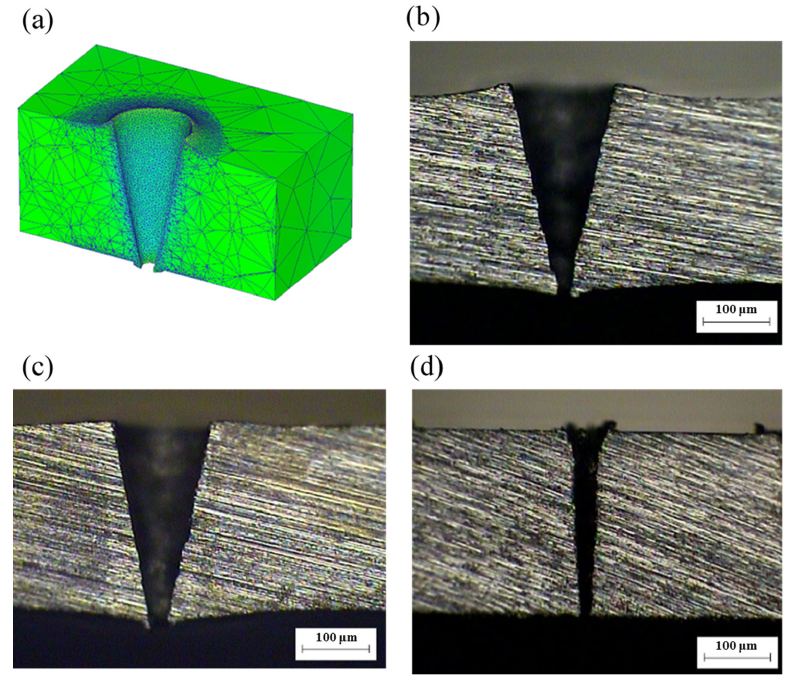
Figure 16. Microhole cross ‐ section ( a ) simulated view ( b ) Punch ‐ Al6061 ( c ) punch ‐ C2680 ( d ) Laser ‐ Al6061.